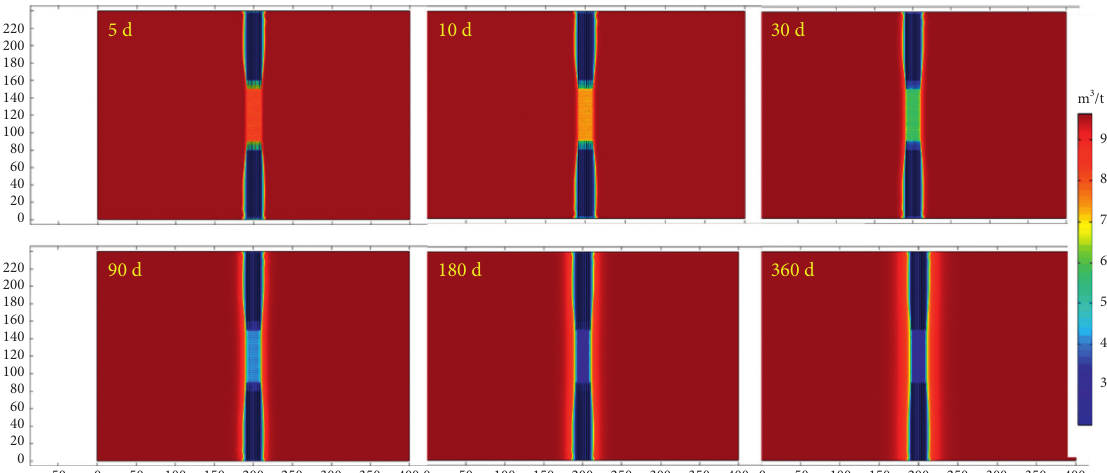
Figure 6: Cloud map of coal seam gas content under different drainage times under the combined drainage of long boreholes along the seam and penetrating boreholes.